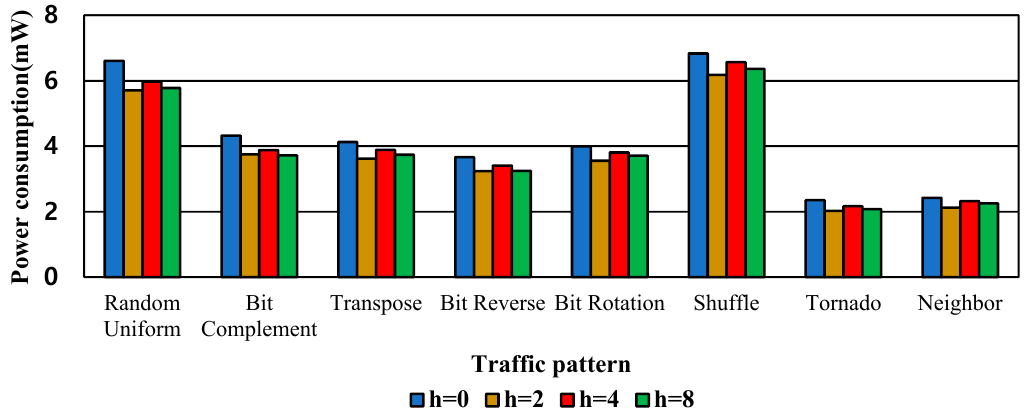
Figure 17. Power consumption of an SOA-enabled HONoC according to the SOA spacing for various traffic patterns.